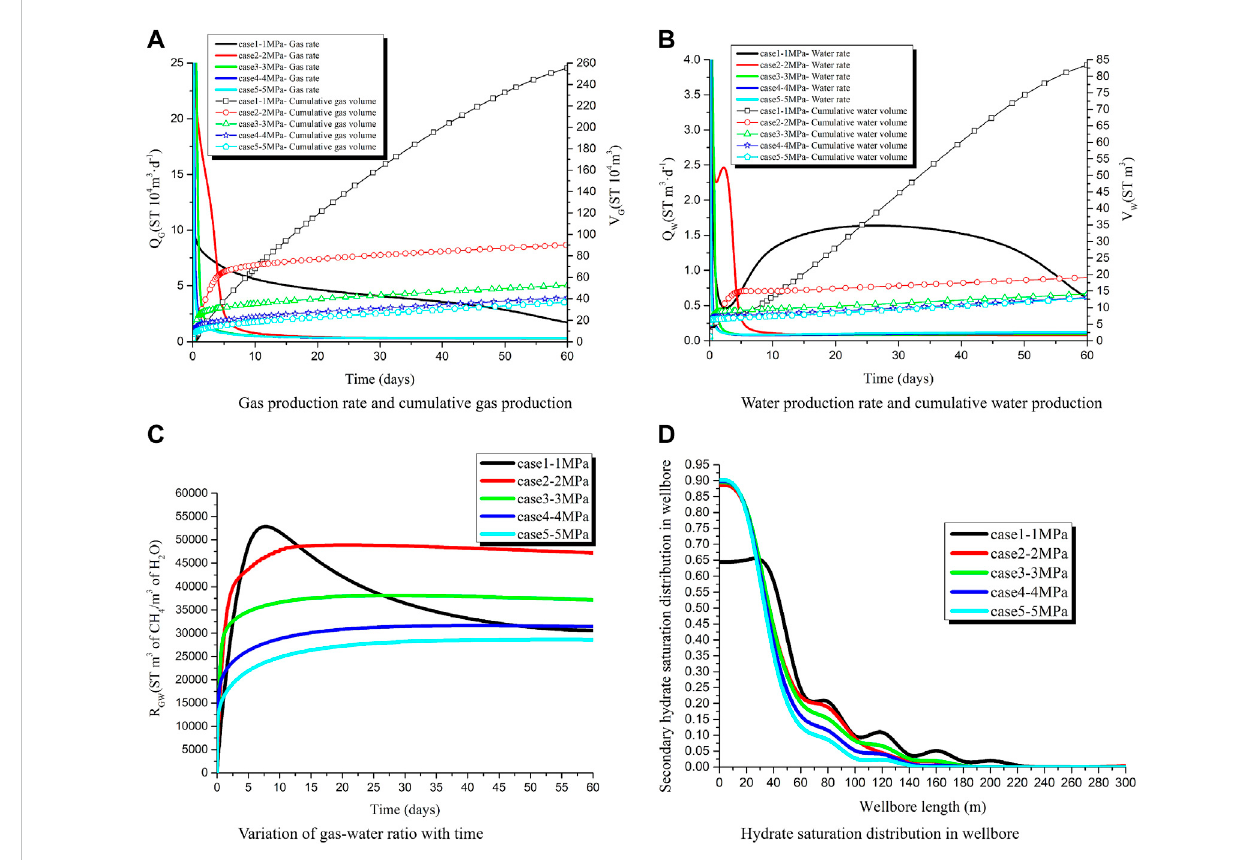
FIGURE 10 Gasproductionrateandcumulativegasproduction (A) ,waterproductionrateandcumulativewaterproduction (B) ,variationofgas-waterratiowith time (C) , and hydrate saturation distribution in wellbore (D) after 60 days of depressurization production with different production